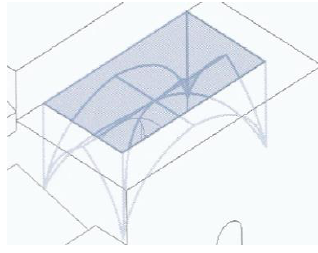
Figure 11. Modelling of cross vaults above the prosthesis.